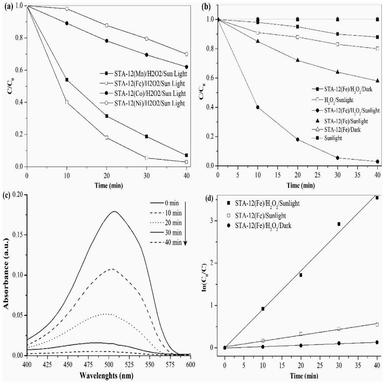
(a) Degradation of MO with STA-12(M) MOFs. (b) Degradation of MO under various conditions. (c) The UV–Vis spectral changes of MO. (d) Comparison of the apparent reaction rate constants of the degradation of MO under different Conditions. Conditions: MO, 10 mg L1 ; H2O2, 8 mM; Catalyst, 0.08 g L1 ; and initial pH 3.